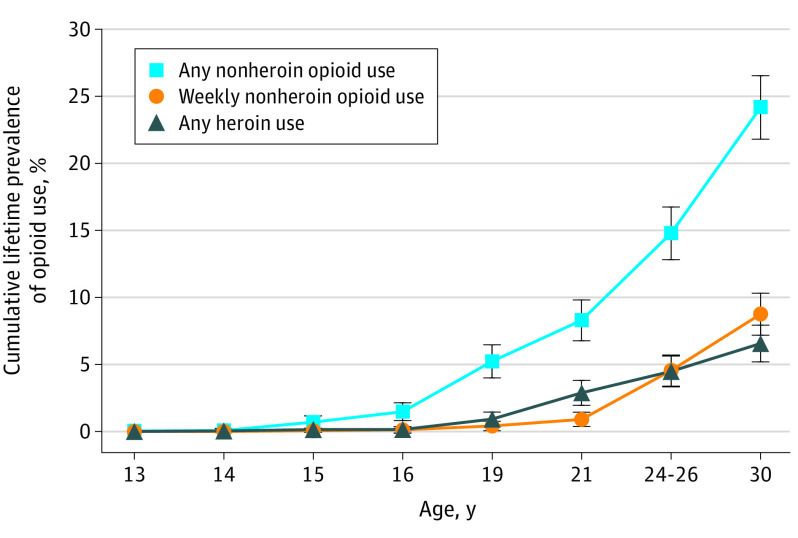
Cumulative Lifetime Prevalence of Opioid Use From Ages 13 to 30 YearsError bars indicate 95% CIs.